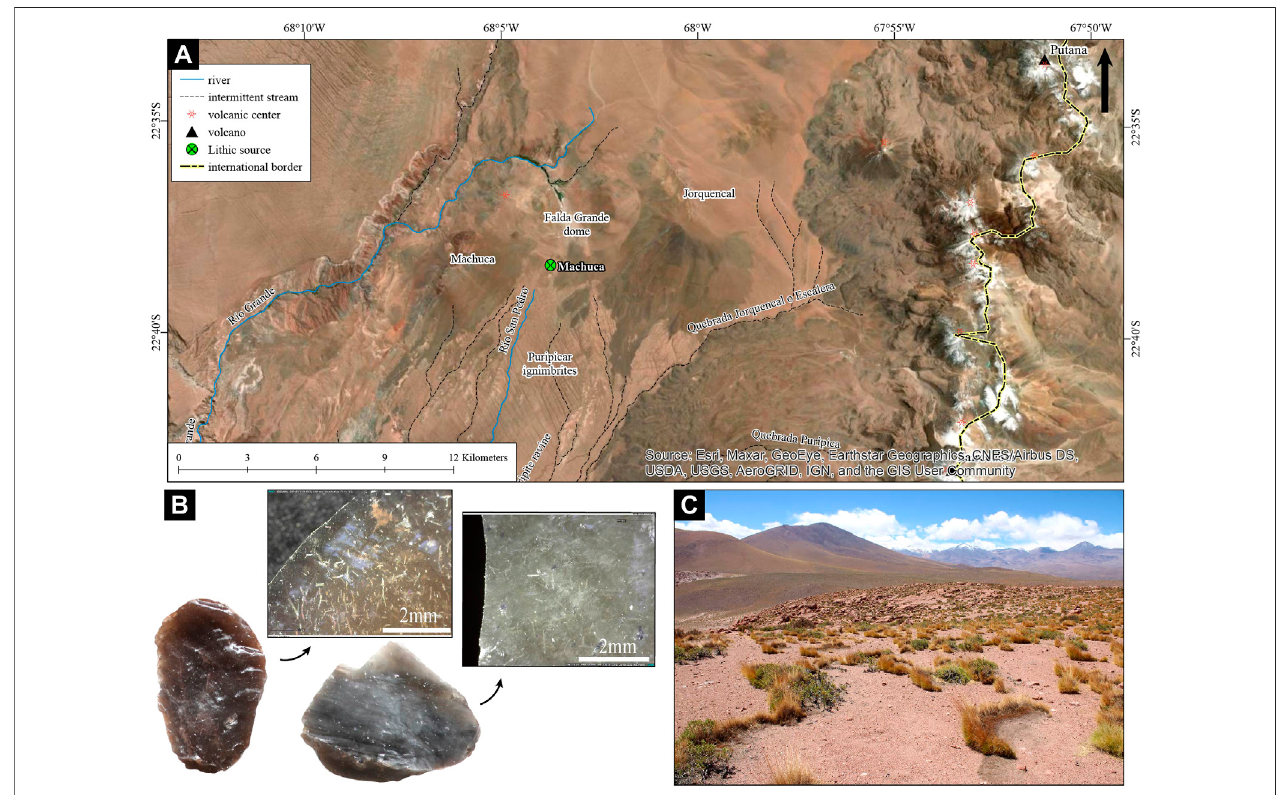
FIGURE 5 | Machuca-Pelún source: (A) geological context; (B) raw material samples; (C) scatter area of raw materials.